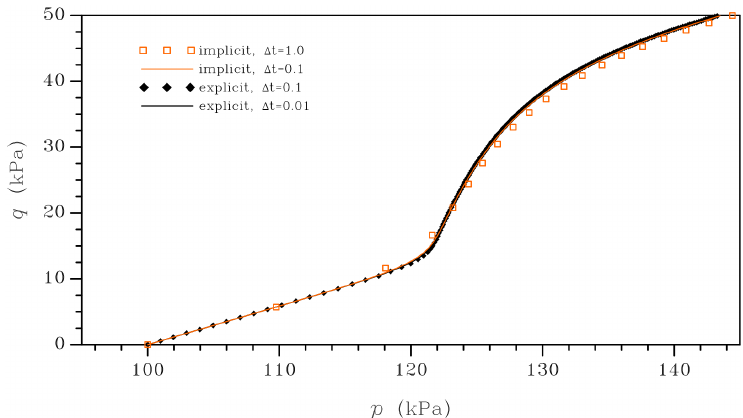
Figure 4. Test 1. Stress point evolution in the p − q